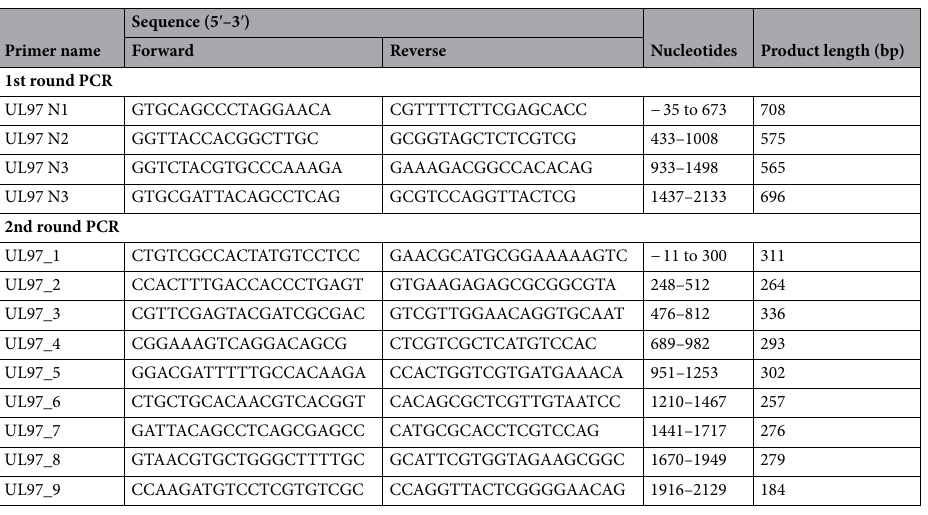
Table 1. Primer sets used in the nested PCR for this